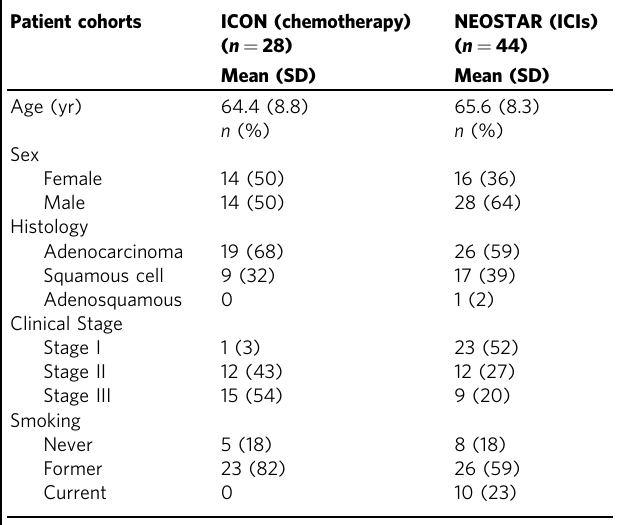
Table 1 Clinical and histopathological patient characteristics in ICON and NEOSTAR